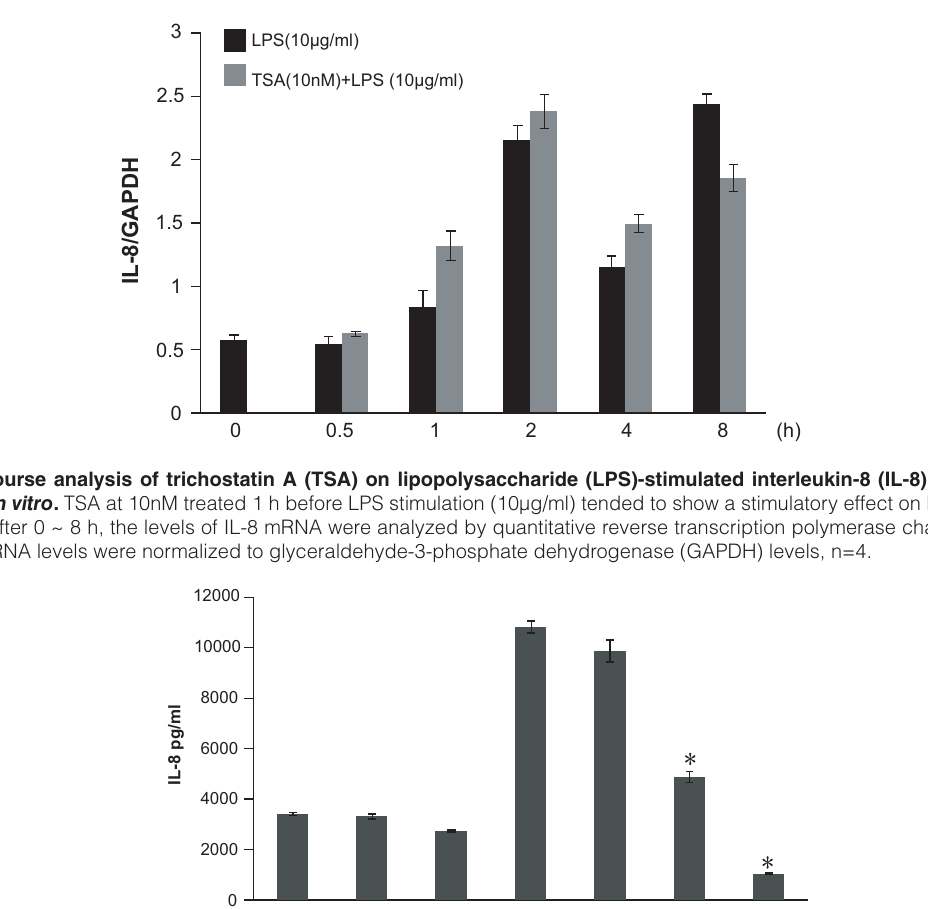
Figure 4. Effect of trichostatin A (TSA) on lipopolysaccharide (LPS)-stimulated interleukin-8 (IL-8) release from A549 cells in vitro . TSA at 1 ~1000nM treated 1 hr before LPS stimulation (10μg/ml) showed a significant stimulatory effect on LPS-induced IL-8 release. Data were expressed as mean±SEM. *P<0.05: compared to LPS-stimulated cells (Mann-Whitney U test), n=4.